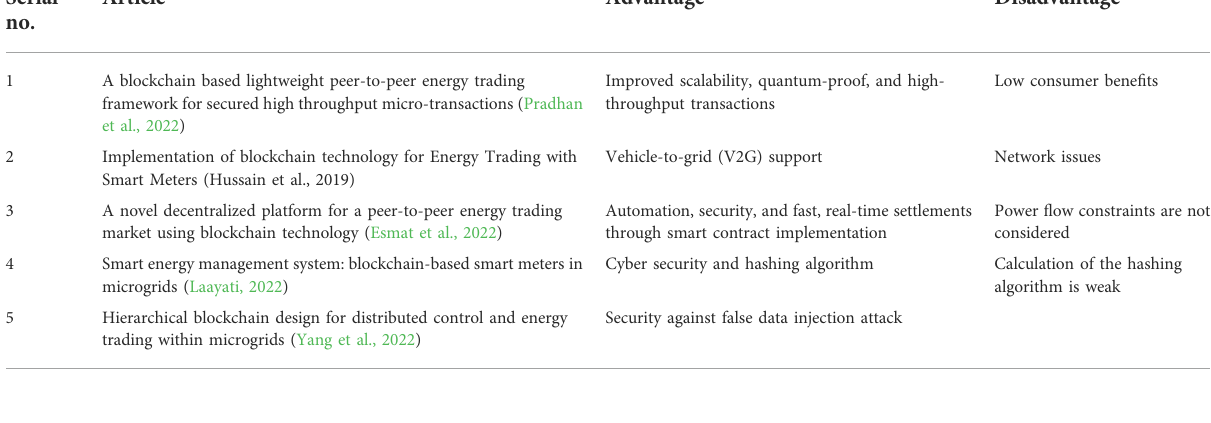
TABLE 1 Literature review with associated advantages and disadvantages. Serial no.